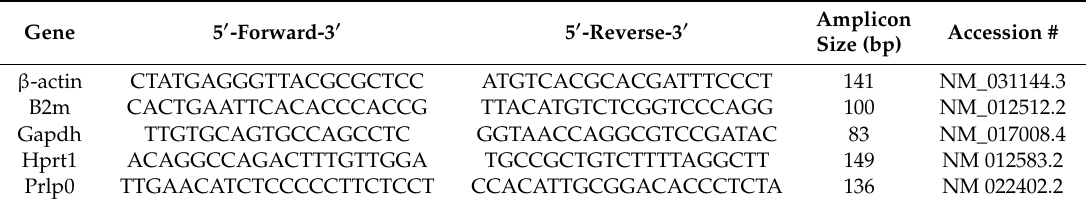
Table 3. Oligonucleotides used for the normalization of the identified burn-induced mit gene expressions.